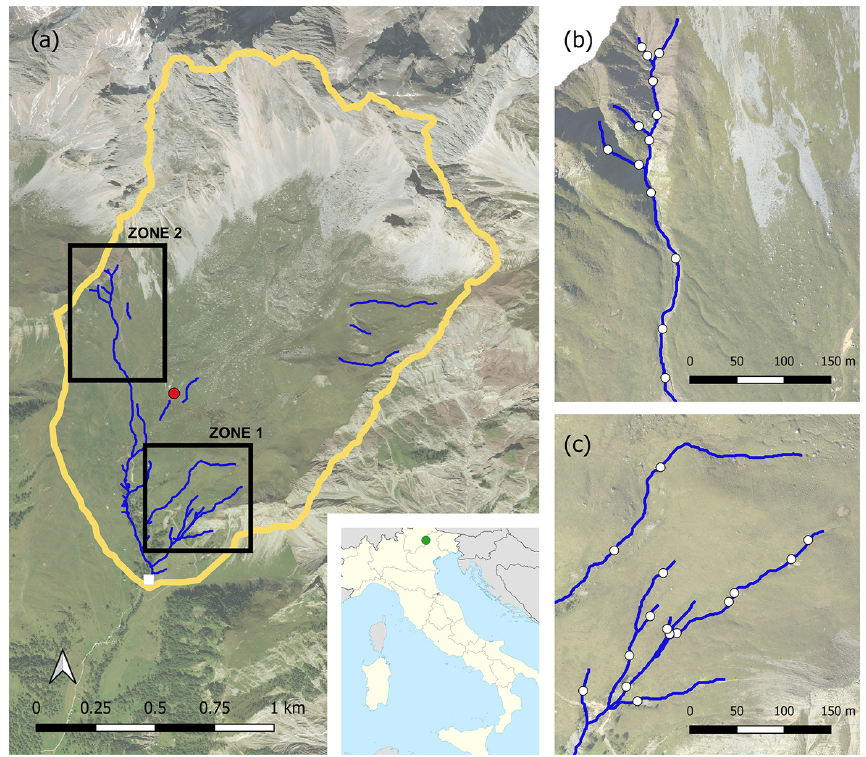
Figure 1. (a) Ortophoto of the Valfredda catchment and its location in northern Italy (green dot), position of the meteorological station (red dot) and the section where discharge measurements were taken (white square). Sensors placed along the tributaries of Zone 1 (c) and Zone 2 (b) . The map was generated with Arcgis Pro 2.7.1 (https://www.arcgis.com/index.html, last access: 4 October